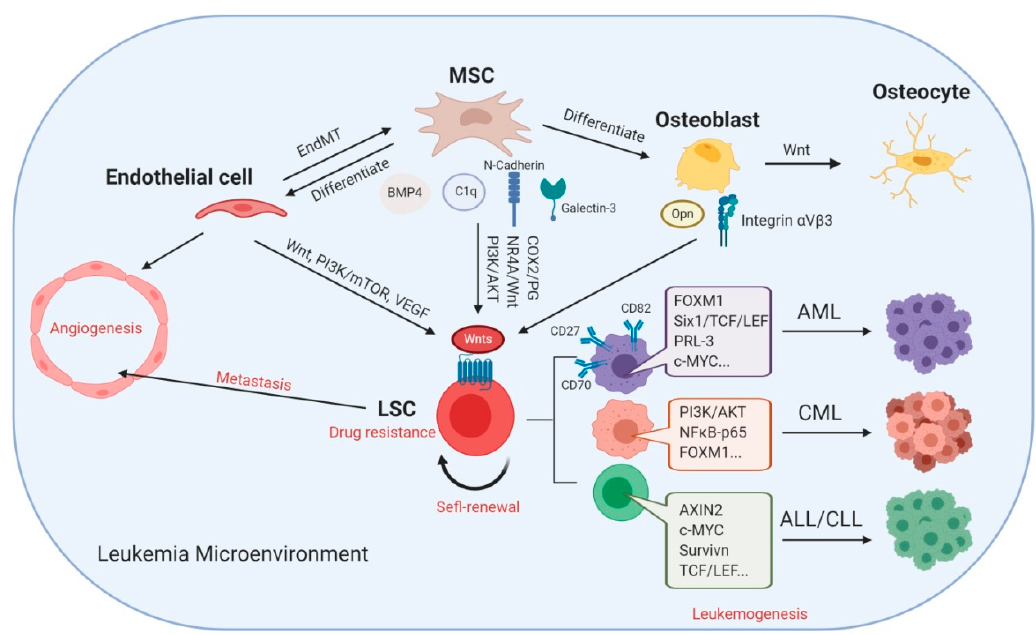
Figure 2. Aberrant Wnt signaling favors disease progression in leukemia. Mesenchymal stem / stromal cells (MSCs) not only directly produce Wnt, C1q, N-cadherin, and galectin-3 while decrease BMP4 initiating Wnt signaling in leukemia stem cells (LSCs), but also differentiate into endothelial cells and osteoblasts, which support LSCs as well. Activated Wnt signaling mediates LSC self-renewal and drug resistance, thereby promoting leukemogenesis. Endothelial cells are not only able to transdifferentiate to MSCs called endothelial–mesenchymal transition (EndMT) effect, but also form new blood vessels called angiogenesis by which LSCs metastasize. Wnt signaling facilitates osteoblast differentiation into osteocytes; meanwhile, osteoblasts promote drug resistance of LSC through osteopontin (Opn) and the integrin pathway. AML, acute myeloid leukemia; CML, chronic myeloid leukemia; ALL, acute lymphoblastic leukemia; CLL, chronic lymphoblastic leukemia.